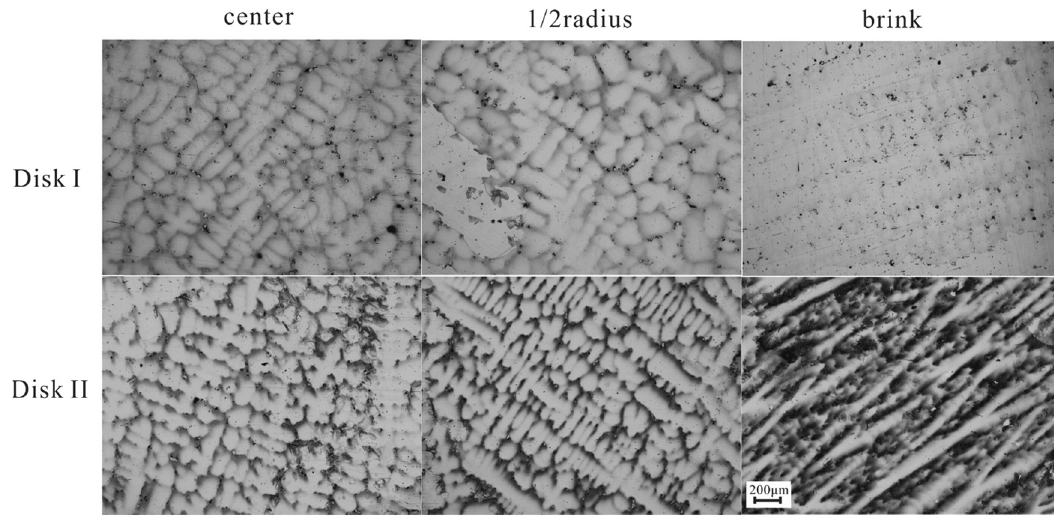
Figure 2: Morphology of as - cast microstructure under OM.